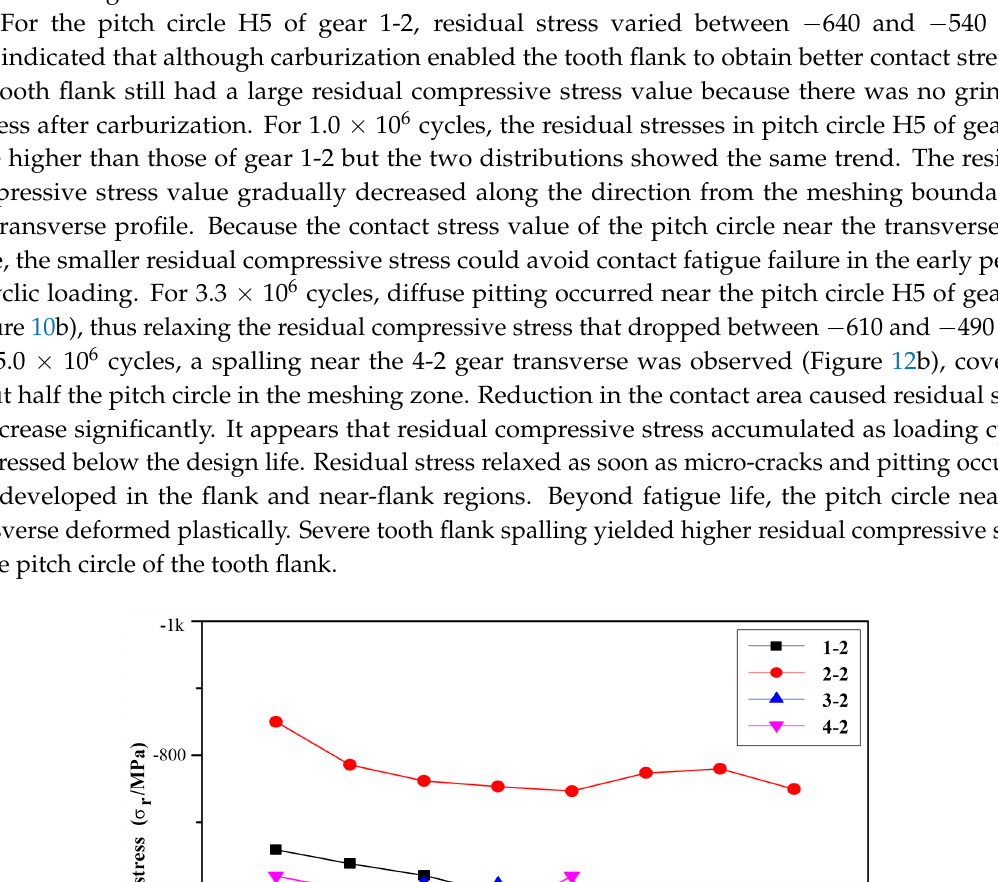
Figure 15. Residual stress distributions curve in the direction from the addendum to dedendum: ( a ) line V2, and ( b ) line V7: control points are at the intersections between lines H1–H12 and V2, V7. For example, point 3 in ( a ) is point (V2, H3) in the tooth flank. The residual compressive stress of line V2 showed a convex distribution with higher values in the central part (Figure 15a). The residual compressive stress value at points 4–6 near the pitch circle was the highest, and it gradually decreased to the lowest at points 11–12 near the dedendum. Similar distributions were obtained for line V7 (Figure 15b). Comparing Figure 15b with Figure 15a, the maximum residual compressive stress transferred to points 6–8, the lower side of the pitch circle. This indicated that the meshing line experienced the maximum contact stress, which led to the most obvious accumulative cycle of the residual compressive stress.